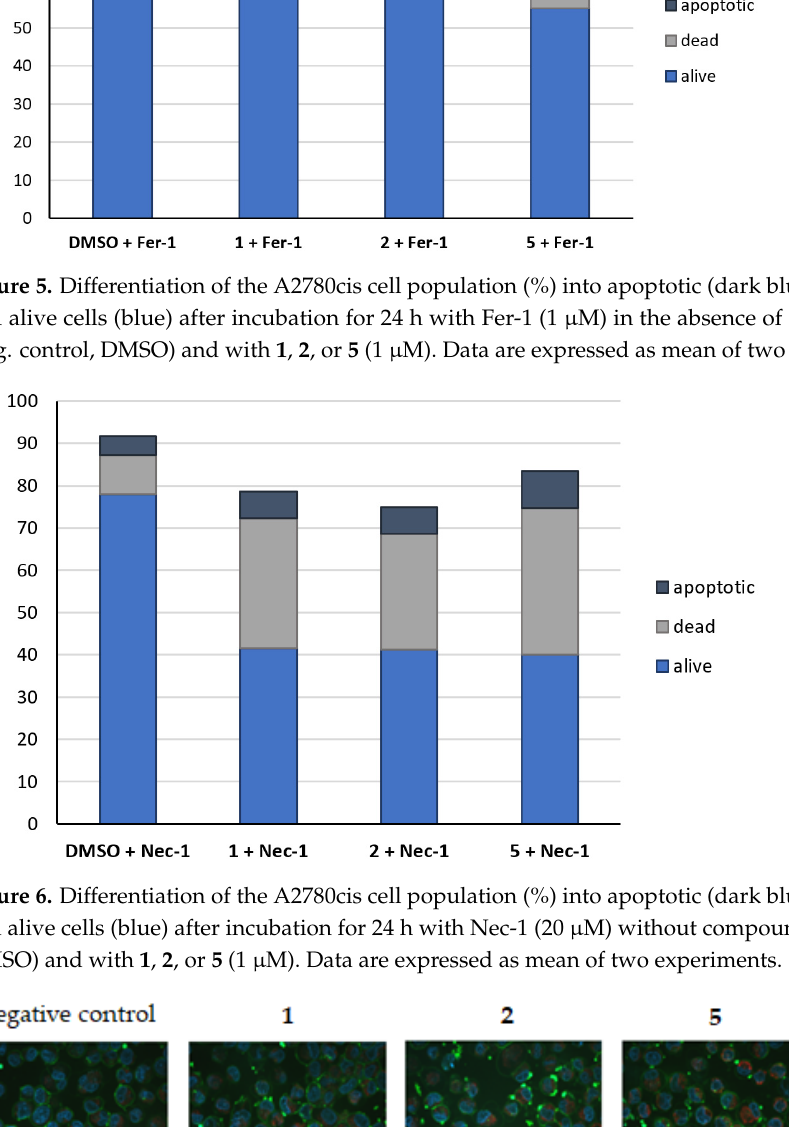
Figure 8. Differentiation of the A2780cis cell population (%) into apoptotic (dark blue), dead (grey), and alive cells (blue) after incubation for 24 h with NAC (1 mM), without compound (neg. control, DMSO), and with 1 , 2 , and 5 (1 μ M). Data are expressed as mean of two experiments. To further investigate the influence of the compounds on mitochondria, the carbocy- anine dye JC-1 was used as a ratiometric indicator of the mitochondrial membrane poten- tial ΔΨ m. JC-1 was added to A2780cis cells for 30 min after an incubation period of 24 h with 0.1 and 0.5 μ M of the compounds. The dye accumulated in the mitochondria depend- ent on the membrane potential and was photometrically quantified. The complexes did